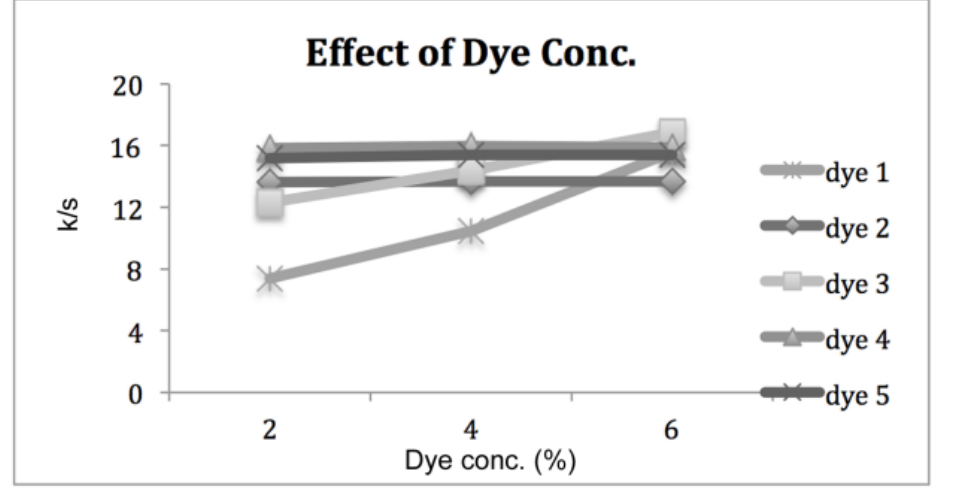
Figure 4. Effect of dye